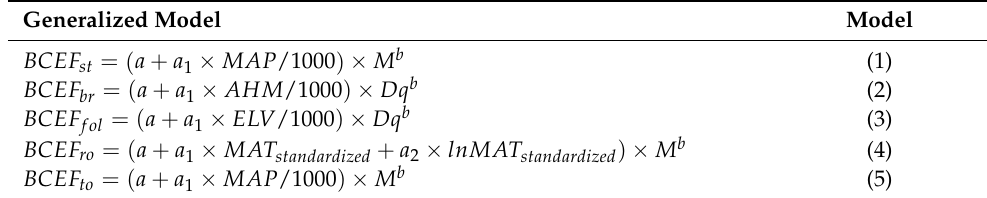
Table 5. Generalized models of biomass conversion and expansion factor of each component.